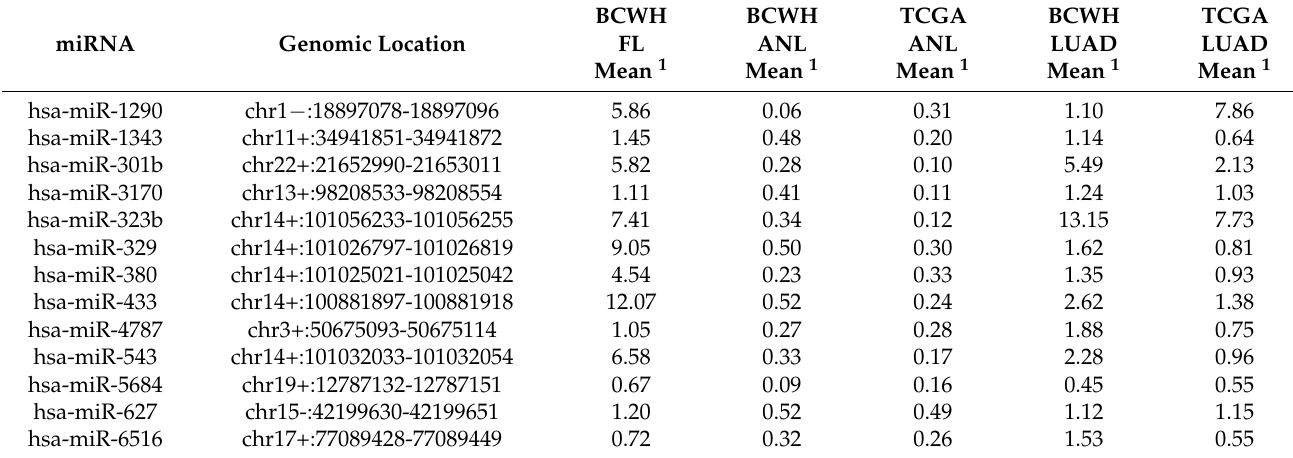
Table 2. Names, genomic locations, and mean expression values of the 13 lung oncofetal miRNAs.